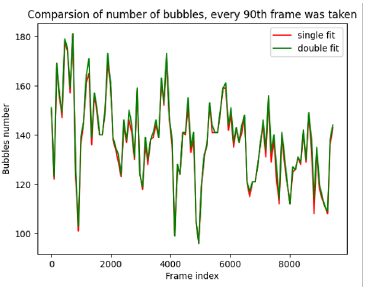
Figure 17. Comparison of bubble number (every 90th frame from F3